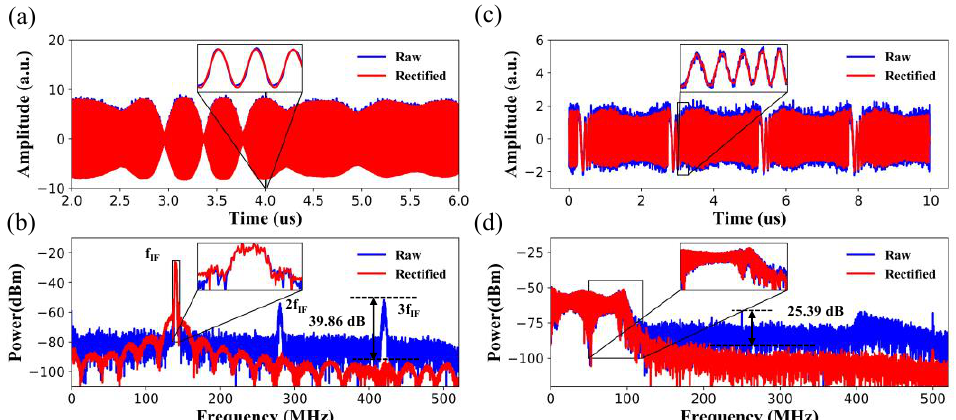
Figure 7. Examples of spurious elimination for the quadrature phase-shift keying (QPSK) commu- nication signal. ( a ) Comparison of the time-domain waveform before and after rectification by the Resnet model; ( b ) Elimination of intricate spurious spectral components and reduction of the noise floor in the frequency domain. Examples of spurious suppression for the linear frequency modula- tion (LFM) radar signal; ( c ) Comparison of the time-domain waveform before and after rectification by the Resnet model; ( d ) Elimination of intricate spurious spectral components and the reduction of the noise floor.